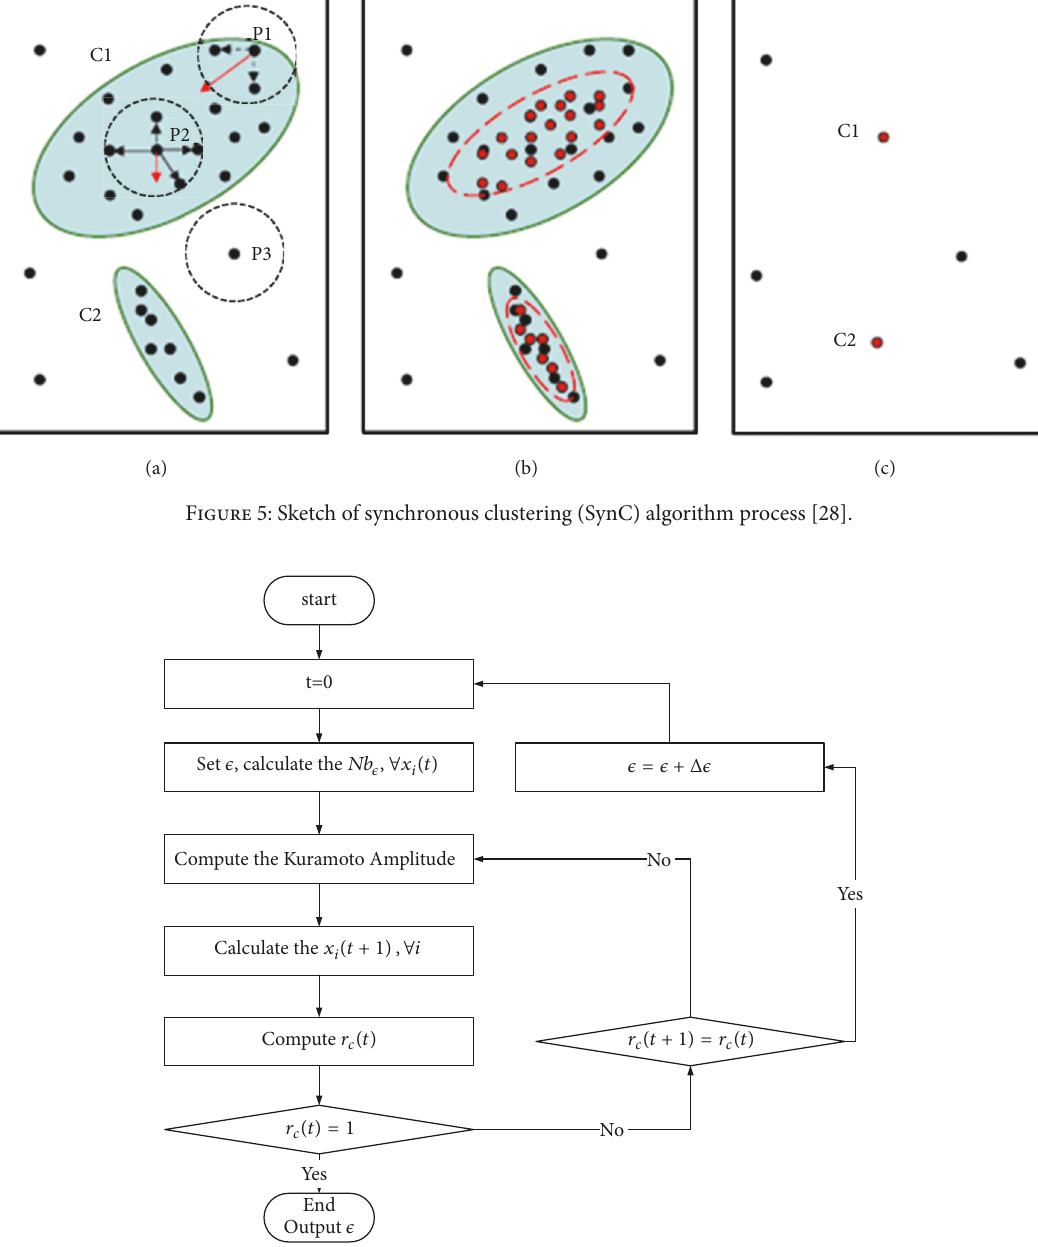
Figure 6: Flowchart of SynC